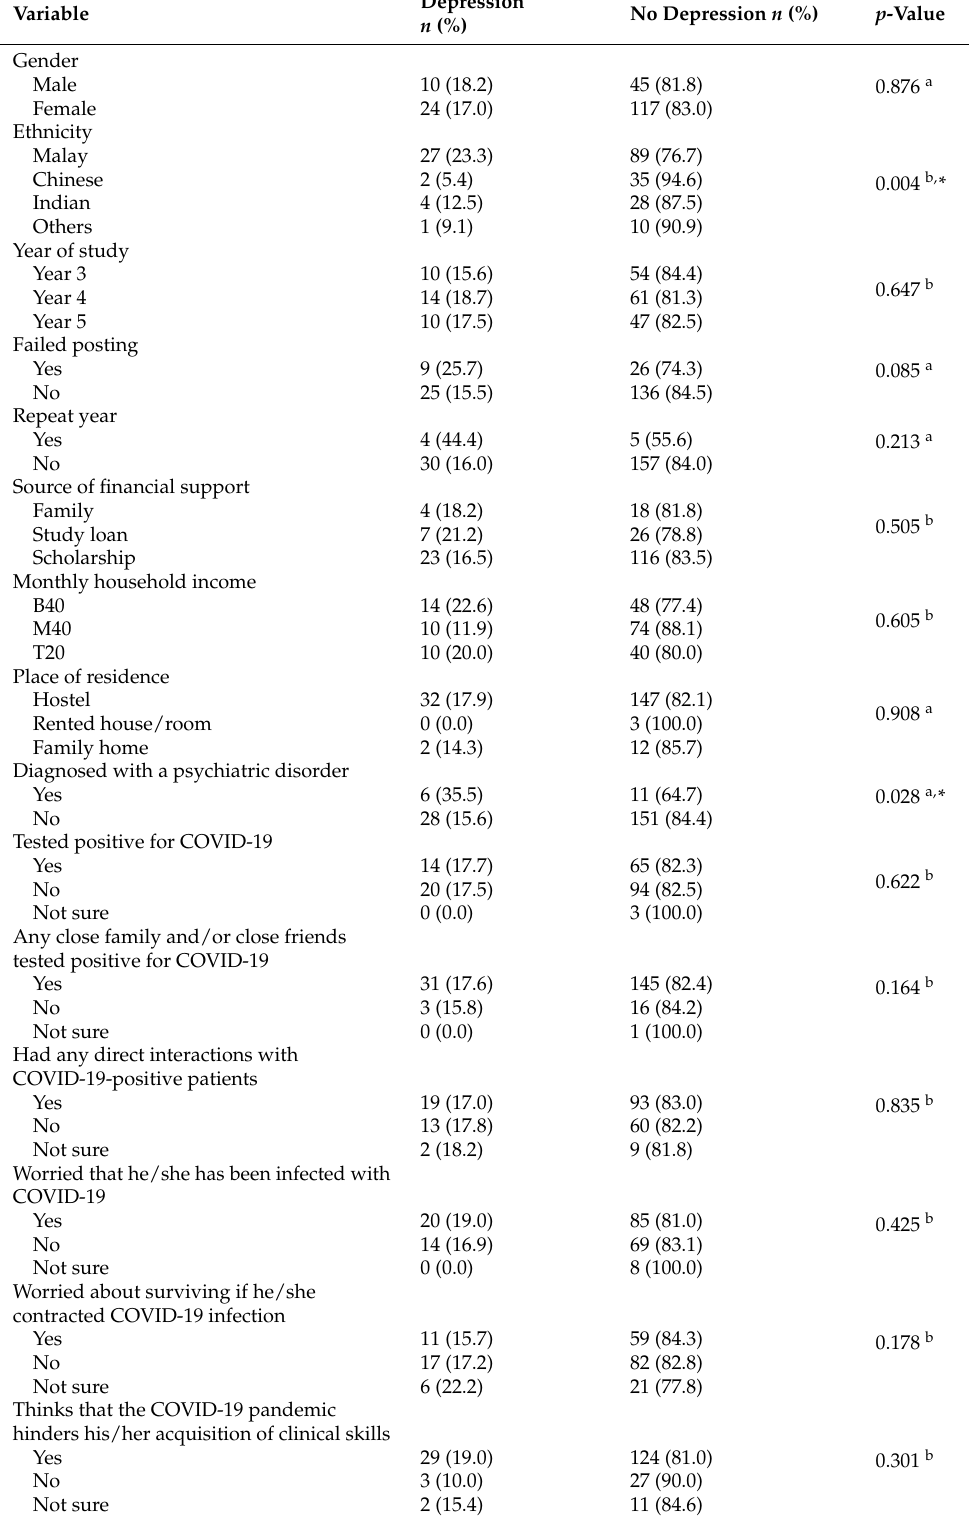
Table 3. Bivariate analyses of PHQ-9 score across categorical